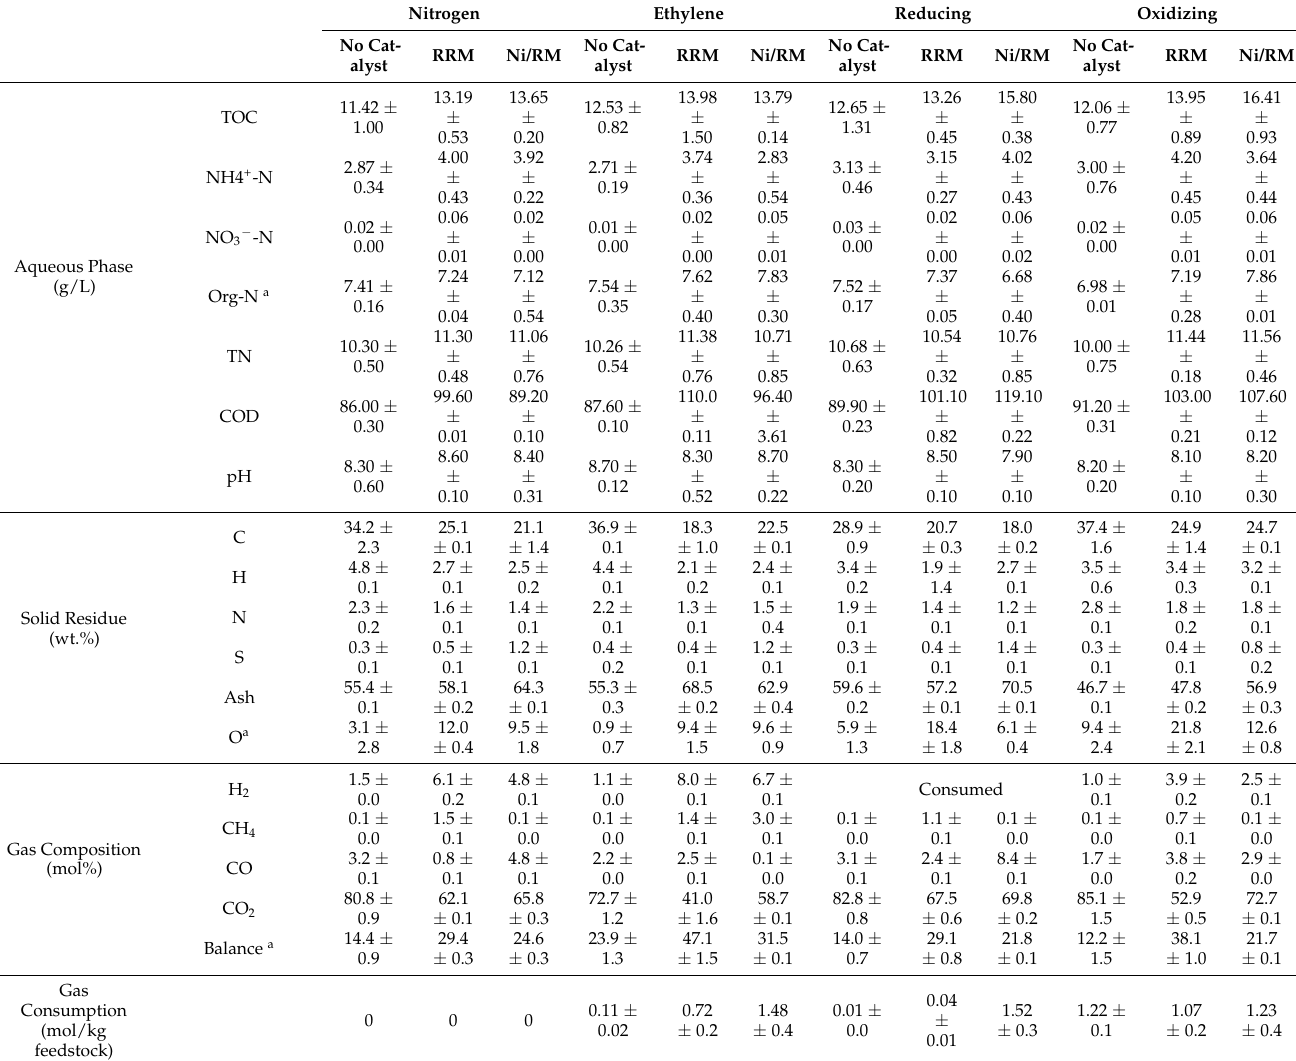
Table 4. Properties of Tetraselmis HTL